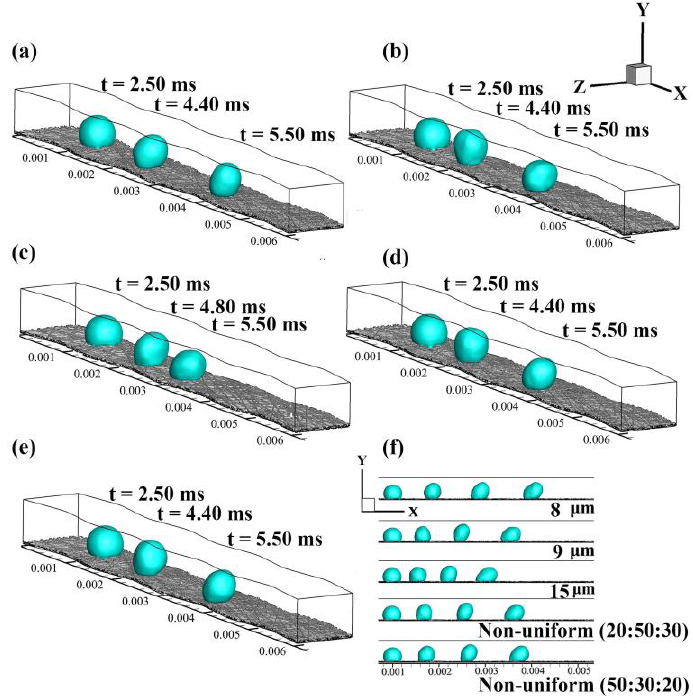
Figure 7. Surface structure effect with fiber diameters ( a ) 8 µm, ( b ) 9 µm, ( c ) 15 µm, ( d ) non-uniform (20:50:30) and ( e ) non-uniform (50:30:20). ( f ) Spatio-temporal droplet positions at different times (2.5 ms, 4.0 ms, 4.8 ms, and 5.5 ms, respectively) on X-Y plane.